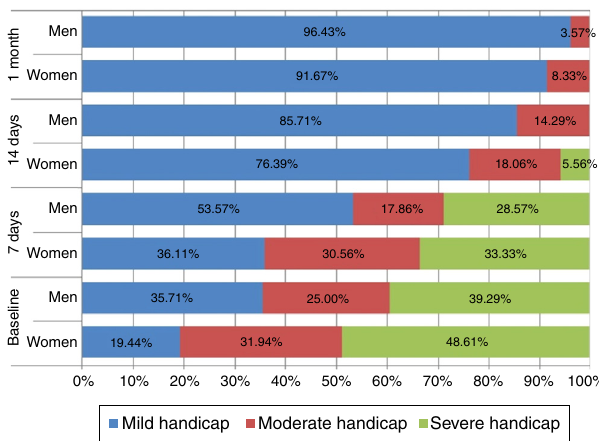
Figure 1 Disability function of the acute unilateral vestibular disorder according to gender.